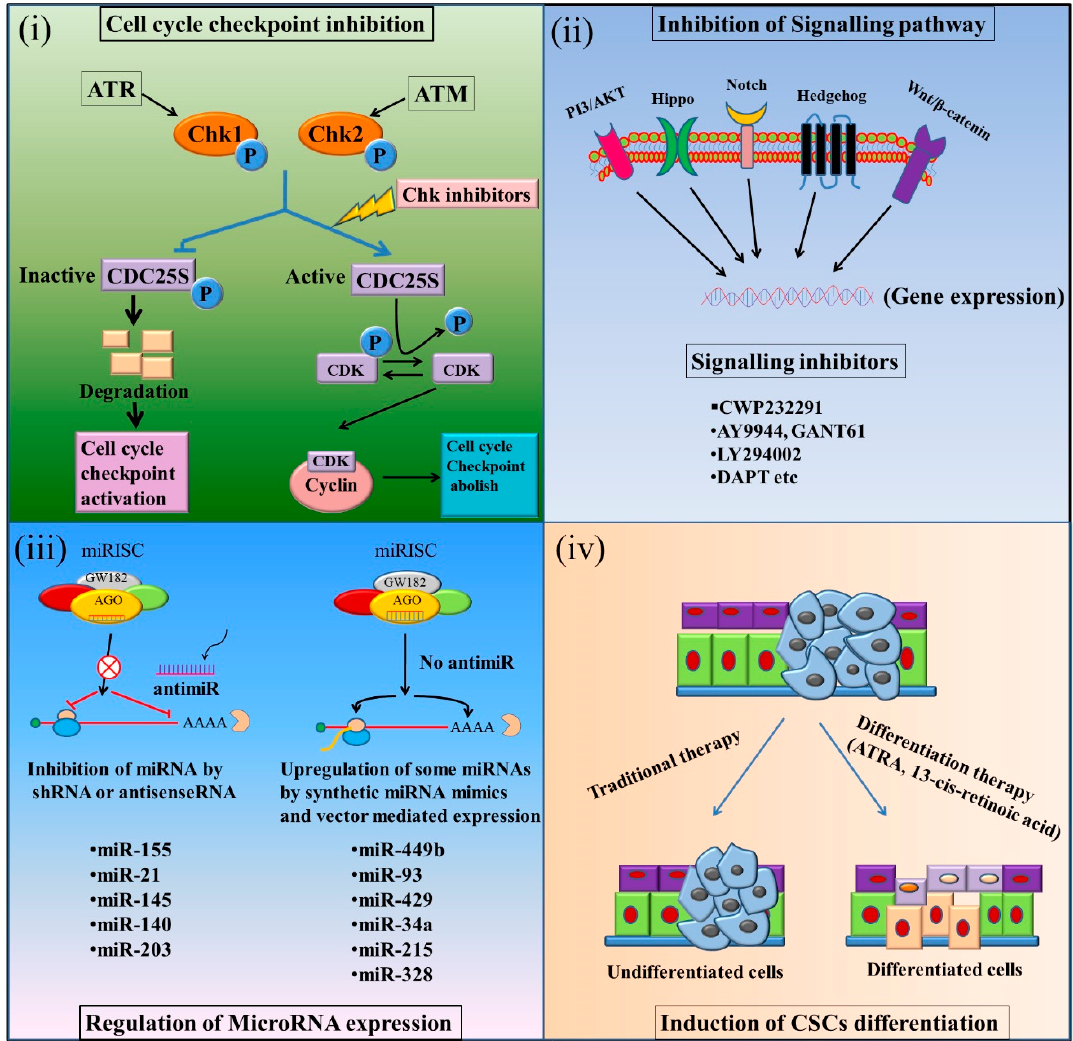
Figure 4. Therapeutic modelling to reduce or inhibit the therapeutic resistance property of CSCs. ( i ) Inhibition of cell cycle checkpoints, ( ii ) Inhibition of hyper-activated signalling pathways, ( iii ) Regulated expression of miRNAs, ( iv ) Induction of differentiation of CSCs.